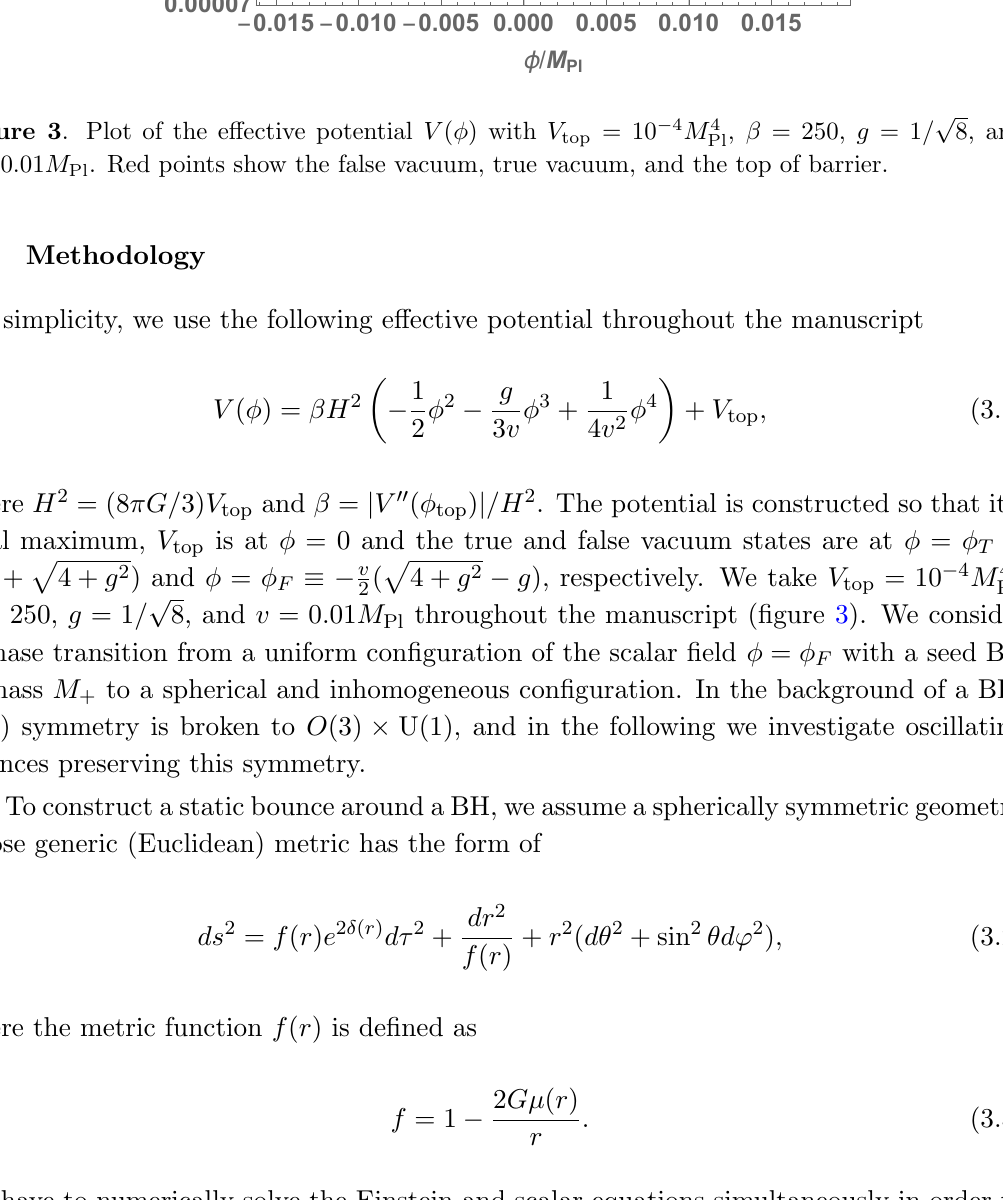
p , (cid:12) = 250, g = 1 = 8, and Pl